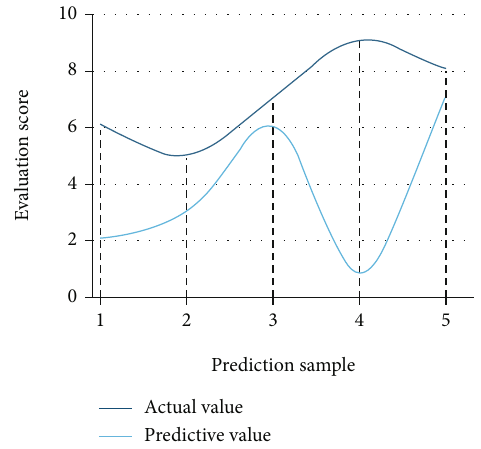
Figure 2: Comparison of teacher ability prediction